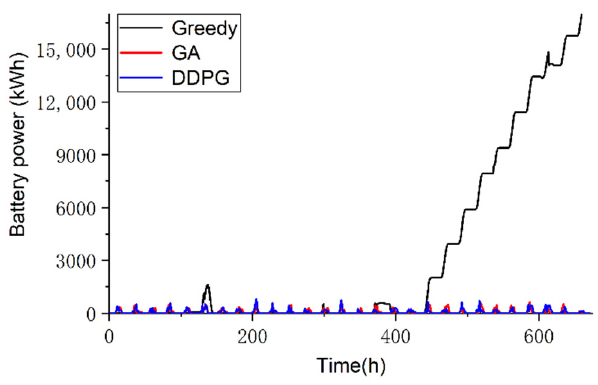
Figure 14. Battery power curve of energy management experiments.